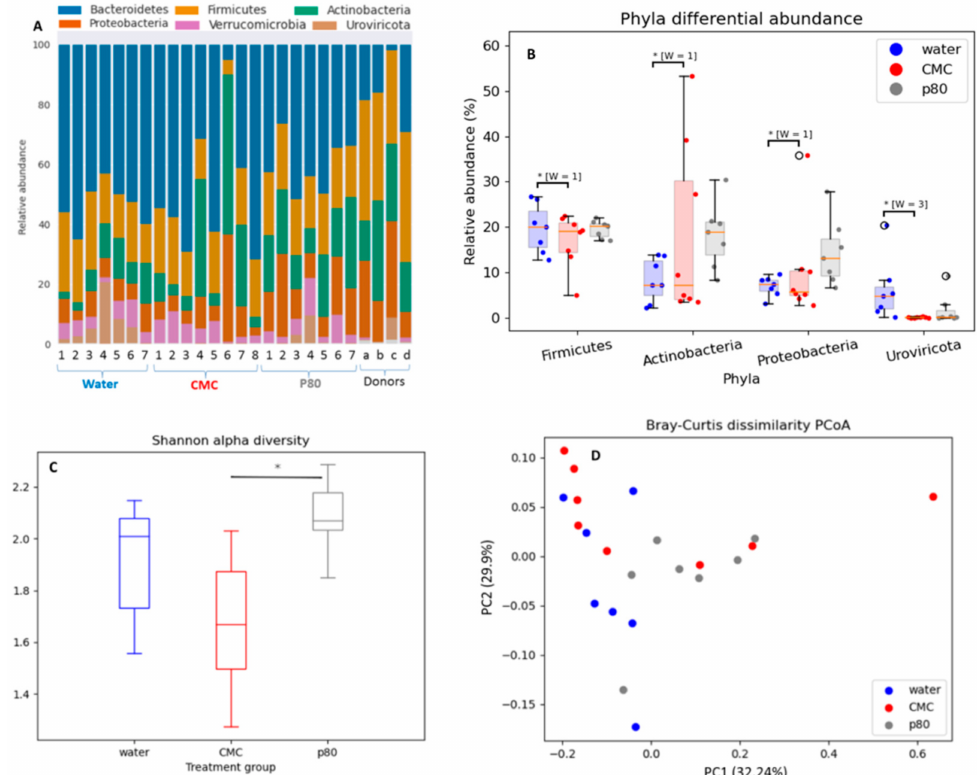
Figure 5. The effect of the CMC (1% w / v , red), P80 (1% v / v , gray), and water (control, blue) on cecal luminal microbiota composition (in percent) ( A ), the relative abundance of top four phyla ( B ), α -diversity in terms of Shannon index ( C ) and β -diversity in terms of Bray–Curtis dissimilarity ( D ) at the phyla levels analyzed by whole genome (shotgun metagenomics) sequencing in humanized IL10 − / − mice after 28 days exposure. Lowercase letters are IBD donors (a–c) and d is pooled feces of patients a, b, and c. Data are the means ± SEM ( n = 7–8). * p < 0.05 by ANOVA with Holm– Bonferroni multiple-testing correction. * [W = X] indicates differential abundance by ANCOM with Holm–Bonferroni multiple-testing correction.